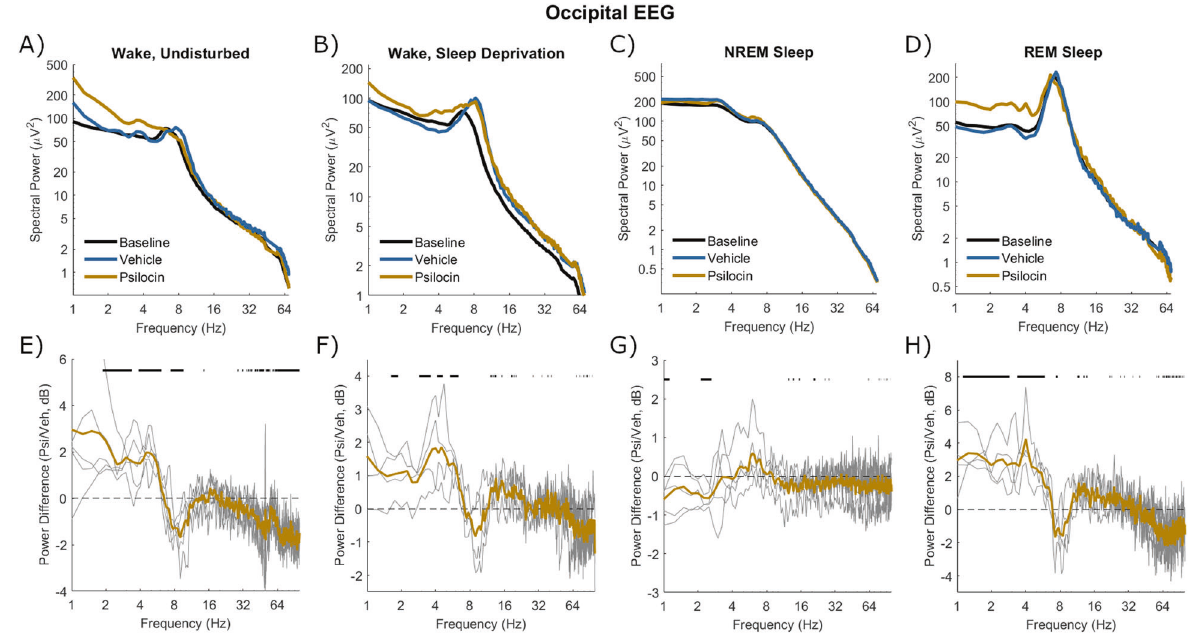
Fig. 6 Spectral power in occipital EEG after vehicle and psilocin injection. The mean power spectra of occipital EEG in four different vigilance state conditions following injection with vehicle (blue) and psilocin (yellow). A ) ‘ Wake, undisturbed ’ corresponds to the fi rst experiment, all wake epochs from injection until the fi rst NREM episode at least 1-minute duration. B ) ‘ Wake, sleep deprivation ’ corresponds to the fi rst 30 min of sleep deprivation in the second experiment. C ) ‘ NREM sleep ’ and D ) ‘ REM sleep ’ correspond to the fi rst experiment, all NREM/REM sleep epochs in the sleep period after injection, de fi ned from the start of the fi rst NREM sleep episode at least 1 min duration until the next wake episode at least 5 min duration. Spectra averaged across the same vigilance state in the baseline day are shown for comparison (black). E – H ) Below each plot illustrates the spectral power difference as a function of frequency in decibels between vehicle and psilocin conditions (positive is greater after psilocin). Grey lines correspond to individual animals and coloured lines to the mean. Black lines indicate discrete frequencies (at 0.25 Hz resolution) that were signi fi cantly different ( p < 0.05) according to paired t